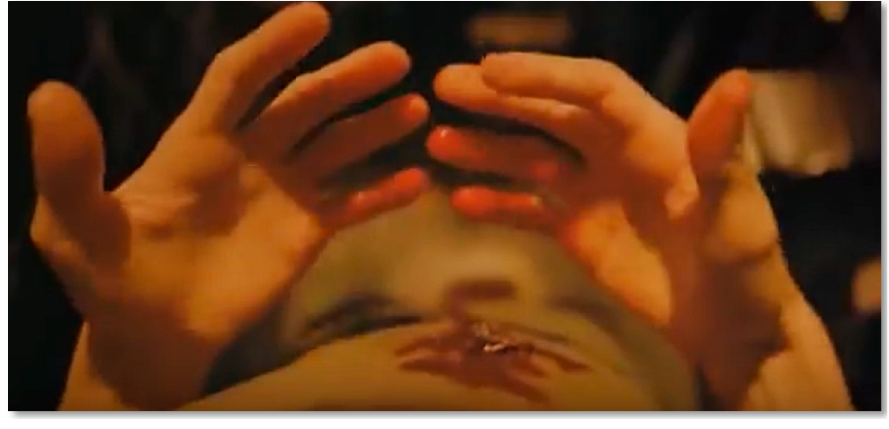
Figure 21. Image from Enter the Void (2009) [53].